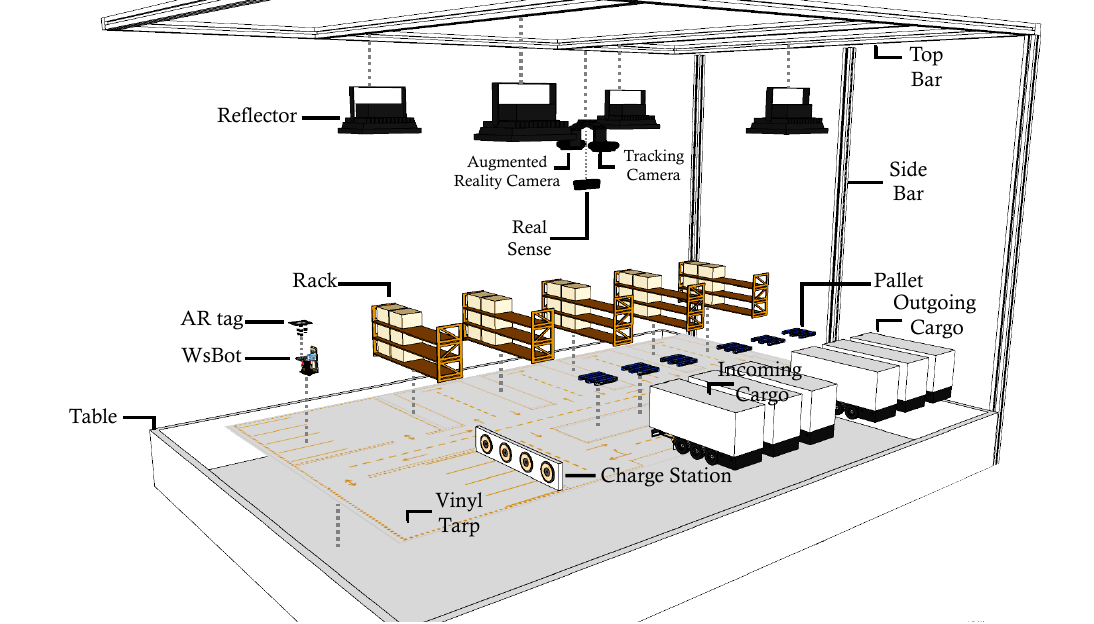
Figure 5. Exploded view of the ARENA’s